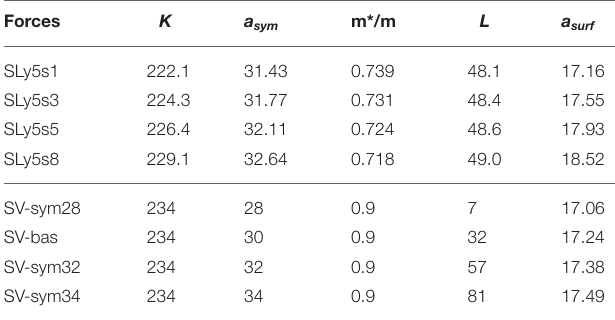
TABLE 1 | The relevant EoS properties of SLy5s X [33] and SV-sym [34] forces are listed, including the incompressibility K (MeV), the symmetry energy a sym (MeV), the effective mass m ∗ / m , the slope of the symmetry energy L (MeV), the surface energy coefficient a surf (MeV).